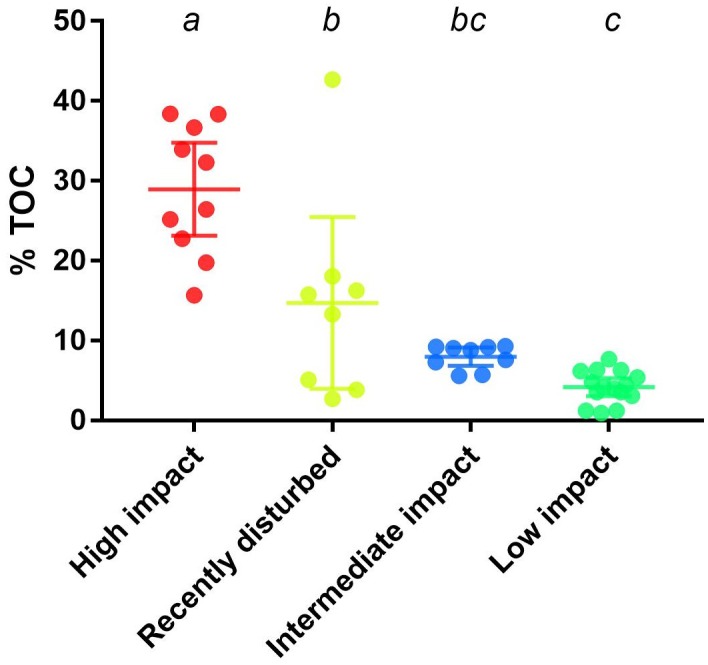
Percentage of total organic carbon across aquaculture impact clusters. Displayed are the measured percentages of total organic carbon (%TOC) from samples in bacterial derived distinct aquaculture impact clusters. Upper and lower whiskers indicate the 95% confidence interval while horizontal lines indicate the cluster %TOC mean. Letters above each cluster shows which groups are significantly (p < 0.05) different.